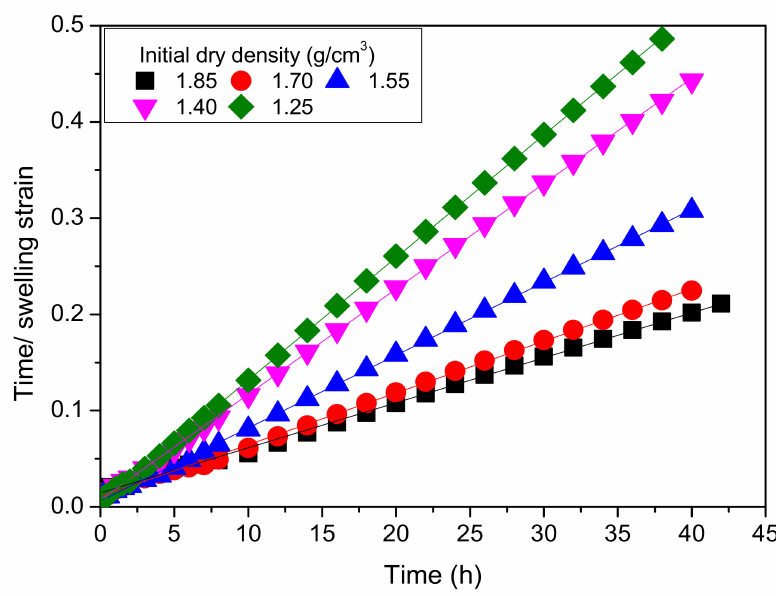
Figure 7. Fitting relationships between ratio of time to swelling strain and swelling time for MB specimens with different dry